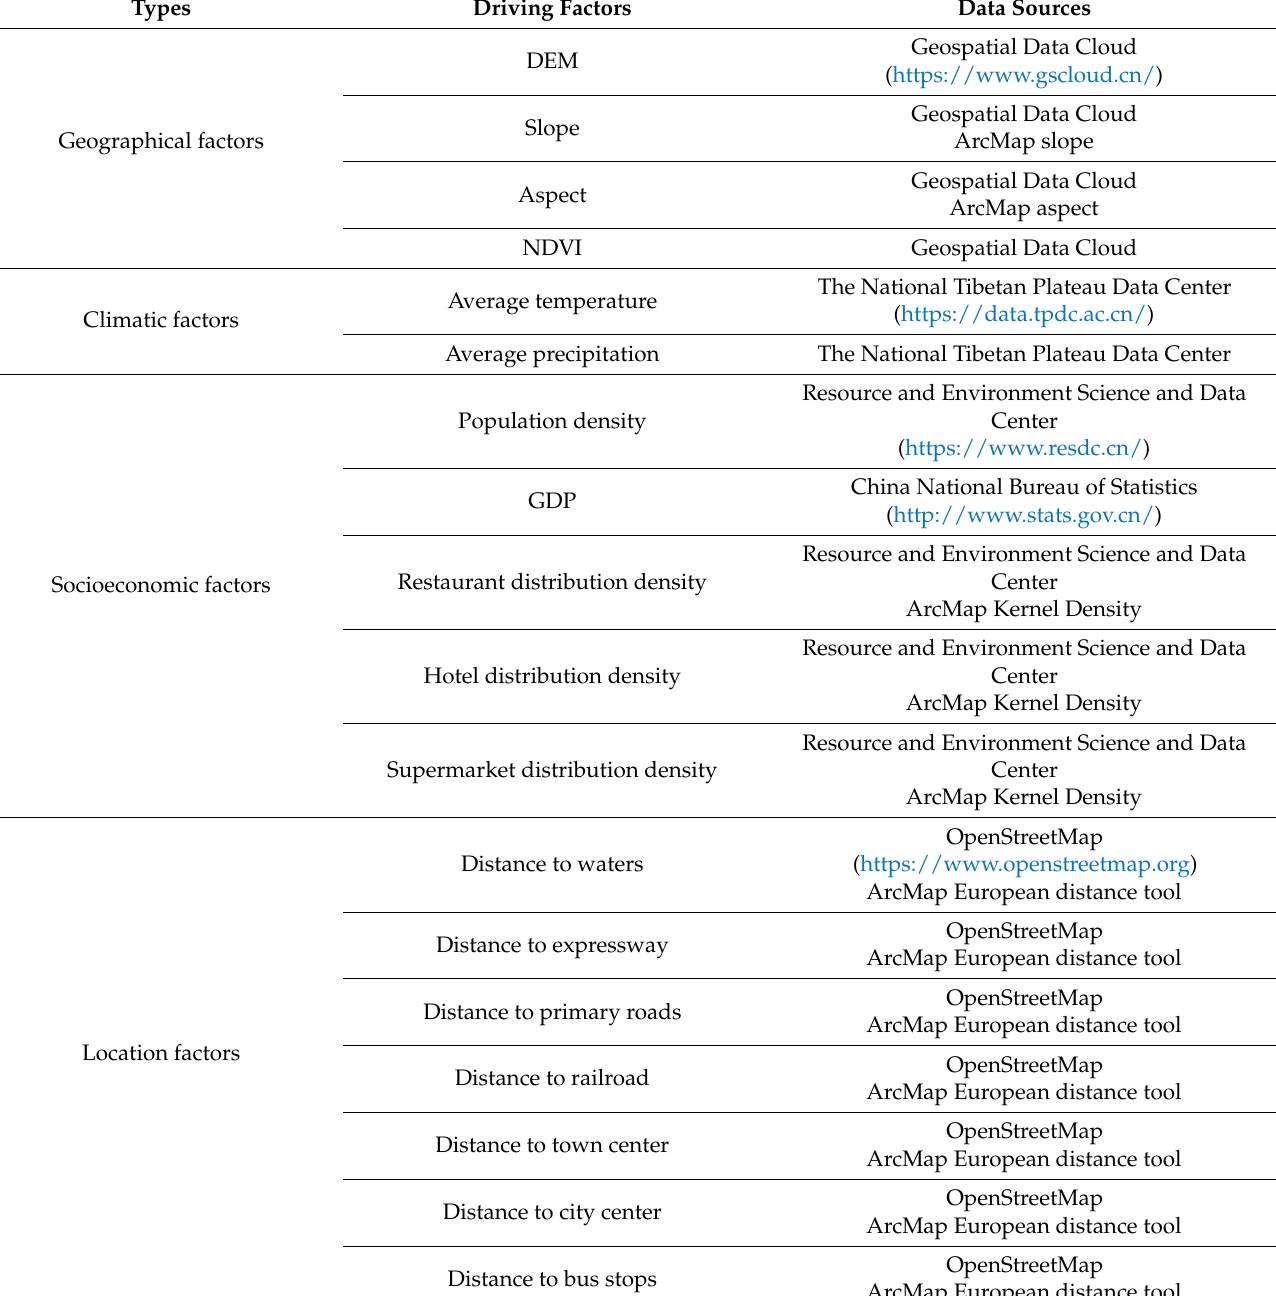
Table 1. List of drivers selected for this